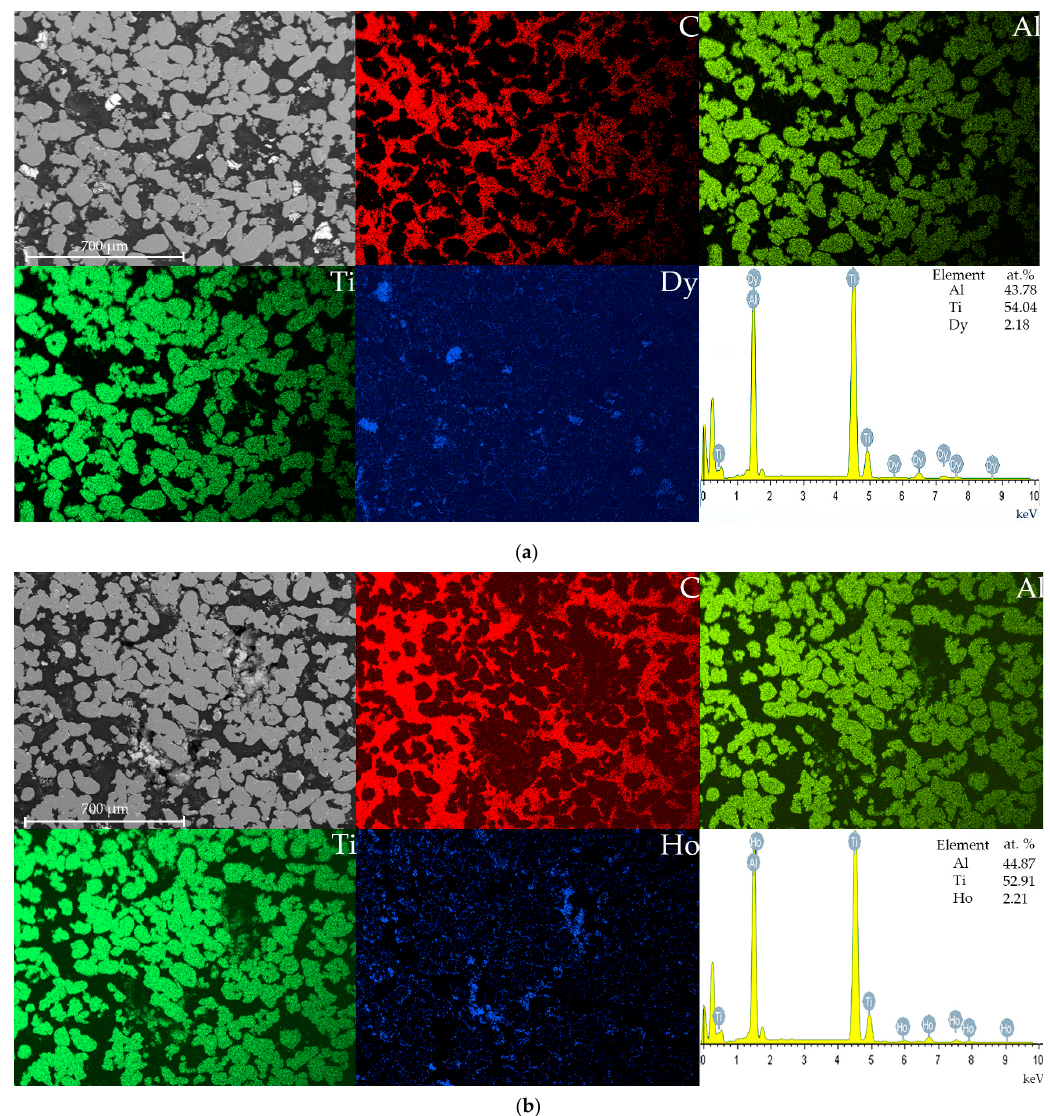
Figure 3. Transmission electron microscopy (TEM) patterns of the TAD ( a ) and TAH ( b ) alloys with super-spectral surface and with EDS analysis spectrum of relevant areas. In the material, there are unevenly distributed areas with a predominance of Dy (lu- minous areas in black-white image) up to 300 μ m in size. The consequence of the modify- ing effect of Dy is a relatively larger average grain size (150 μ m) of the studied experi- mental Dy-containing gamma alloys in contrast to alloys with Sc and Y microadditives (100 μ m) [35,36]. Grains with an average size of 110–130 μ m were formed on the TAH specimen surface. The addition of Ho to the Ti-Al system leads to the formation of smaller grains compared to Dy. Rounded Dy-containing phases are observed in different parts of the matrix during EDS analysis directly in the places of accumulation of various kinds of inclusions (Figure 3). It was established that the TAD alloy matrix consists only of Al and Ti particles during local EDS analysis. The results obtained are in good agreement with the data [37]. Dy and Ho are concentrated at grain boundaries as shown in Figure 3. It should be noted that the presence of carbon is due to the use of a conductive com- pound into which the specimen is pressed. Since the specimens have a porous structure, the compound fills these pores during processing (grinding-polishing) and is identified as carbon during mapping. The particles morphology formed at grains boundary has been studied in detail. Fig- ure 4 shows that dark particles with an average size of 0.51 μ m are located on the surface, and larger particles (approximately 1.14 μ m) are located at the grain boundary for the TAD specimen. For the TAH specimen, the average size of the formed particles are 1–1.3 μ m. Moreover, the particles enriched with Ho (in the TAH specimen) form clusters (chains) among themselves.